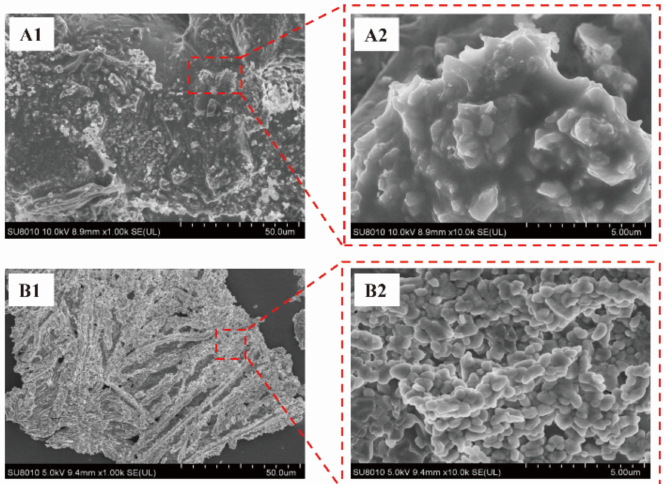
Figure 3. SEM pictures and structural characterization of ( A1 , A2 ) ABPs, and ( B1 , B2 ) peptide–calcium chelate. ( A1 ) ABPs at × 1000 magnification; ( A2 ) ABPs at × 10,000 magnification; ( B1 ) peptide–calcium chelate at × 1000 magnification; ( B2 ) peptide–calcium chelate at × 10,000 magnification.